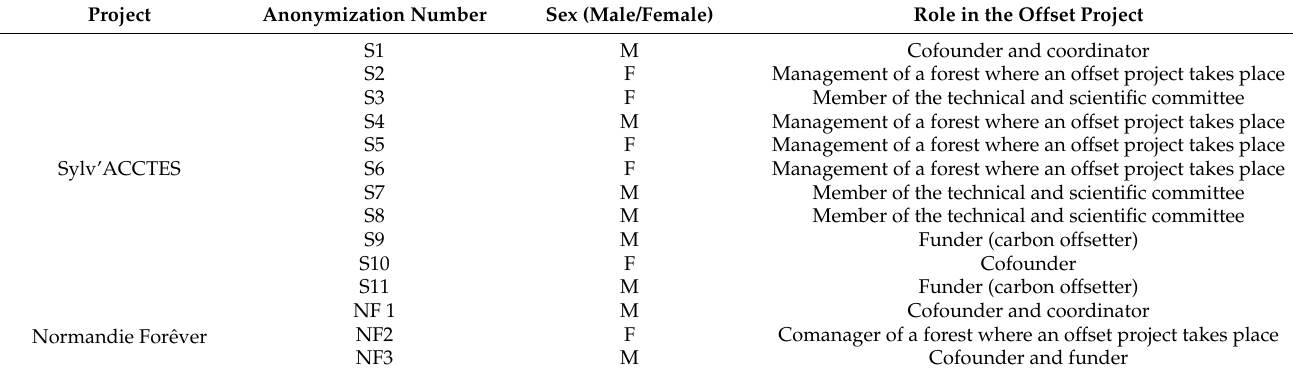
Table A2. Overview of the interviewees.